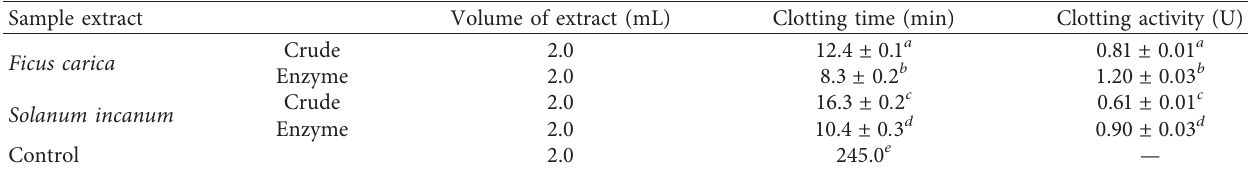
Table 5: Clotting activity of sample extract.